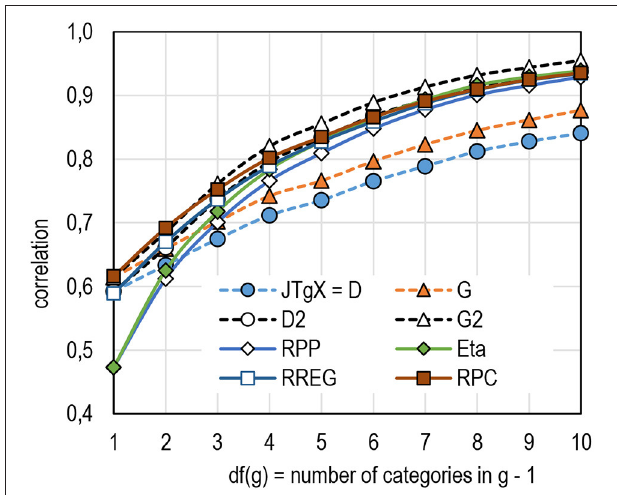
FIGURE 3 | Average estimates by the number of categories in the item (k = 14,888 items). Eta Coefficient eta is a close sibling to Rit ; with binary and dichotomous items, eta = Rit (see [60, 61]), and with polytomous items Rit follows closely the direction of η ( g | X ), henceforth, just eta , usually denoted as “ X dependent”—which is the same direction as in D ( g | X )—and not the opposite direction η ( X | g ) (see [2]). This is its traditional direction in settings related to GLM (“ X dependent”). One of the advances of eta over Rit is that, unlike Rit , eta can detect the possible non-linear pattern in the item, and, hence, in the polytomous settings, the magnitudes of the estimates by eta are always somewhat higher than those by Rit (see the algebraic reasons in, for example